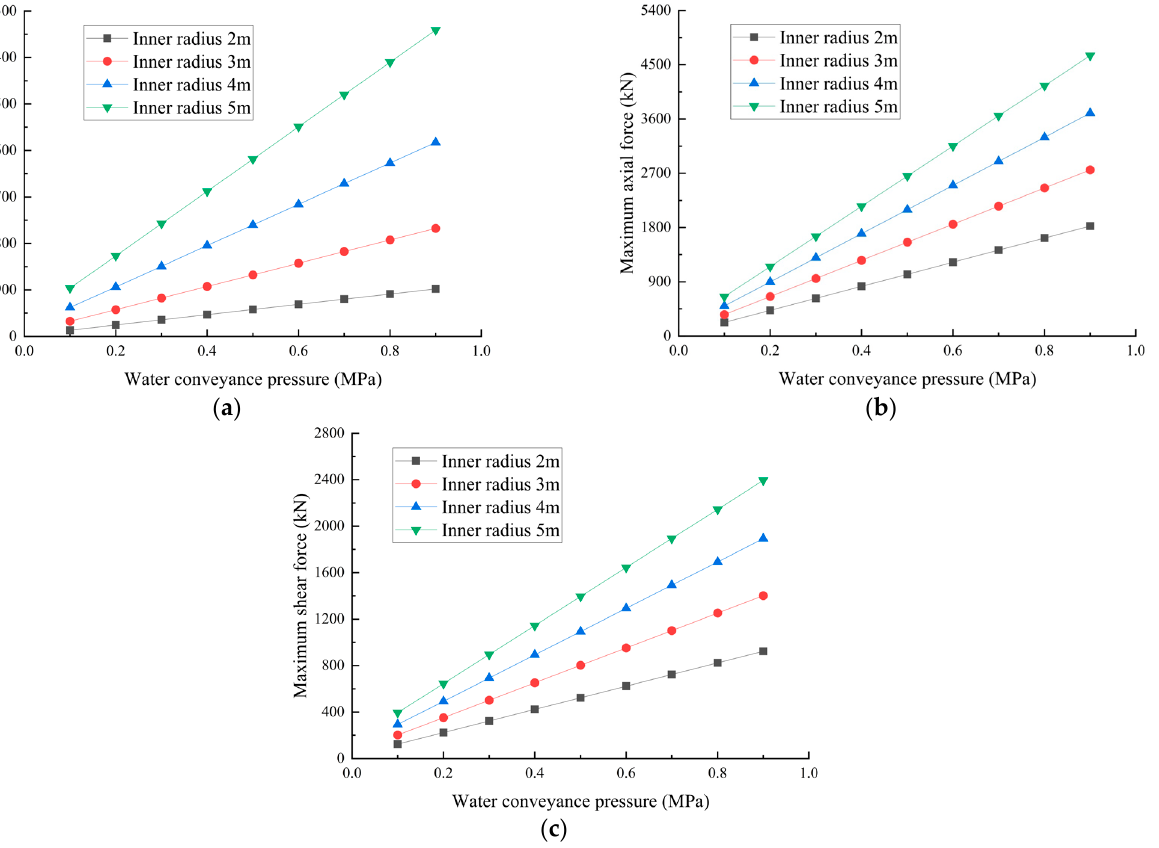
Figure 7. Influence of pressurized water conveyance pressure on the maximum internal force of lining. ( a ) Maximum bending moment. ( b ) Maximum axial force. ( c ) Maximum shear force.